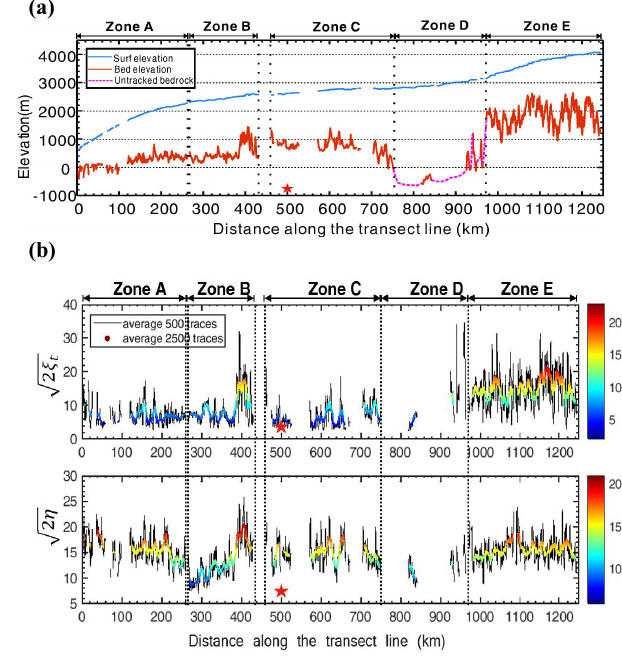
Figure 3. (a) Surface and bed elevation, (b) basal roughness from Zhongshan to Dome A. The black line indicates the result from 500 trace moving windows, and the color scatter is the result from 2500 trace moving window. The red star marks the location of Taishan